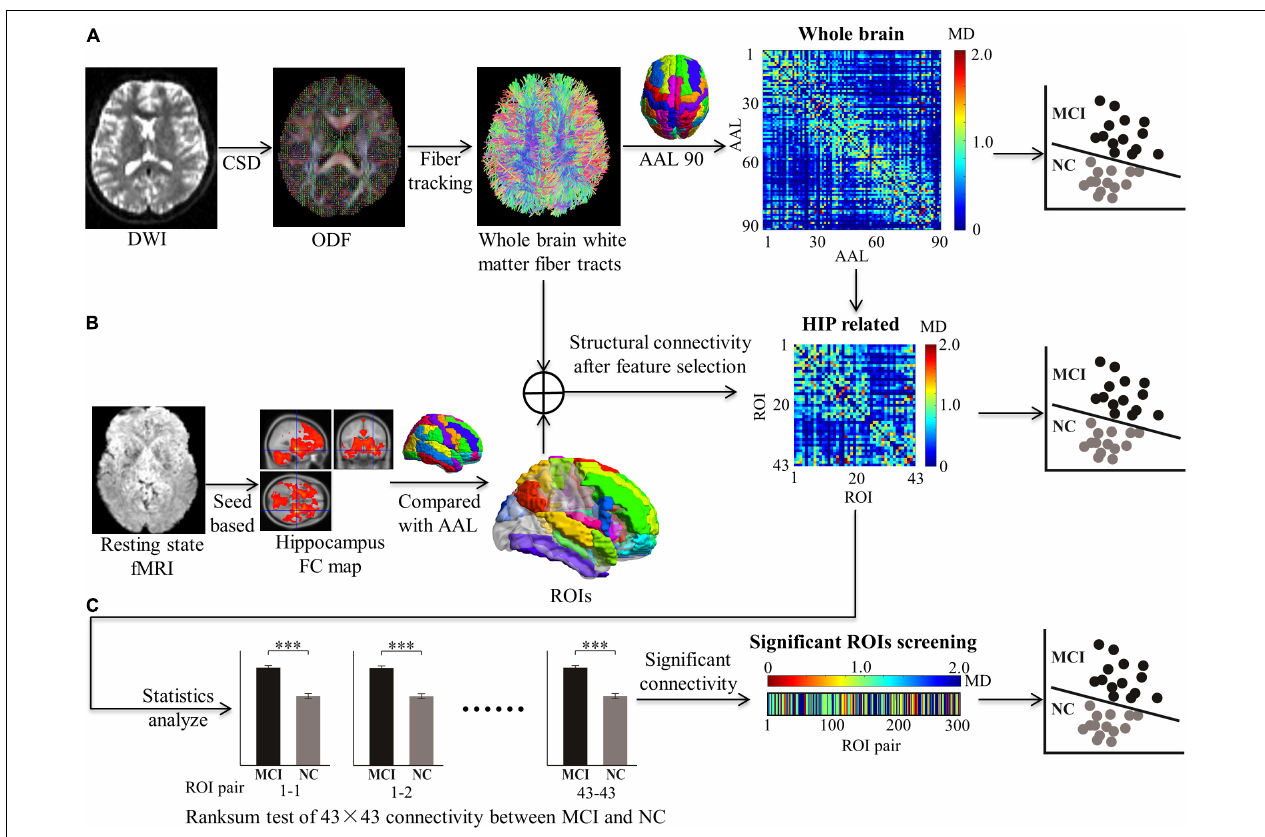
FIGURE 1 | Feature extraction in structural connectivity map driven by hippocampus related ROIs. Three kinds of features were extracted for MCI classification, including: (A) The whole brain WM network was acquired from diffusion MRI with all 90 × 90 AAL regions. (B) The HIP related WM network was selected by 43 × 43 ROIs from the whole brain WM network. (C) The significant HIP related WM network was acquired (* p < 0.05, ** p < 0.005, and *** p < 0.0005; ranksum test with bonferroni correction).